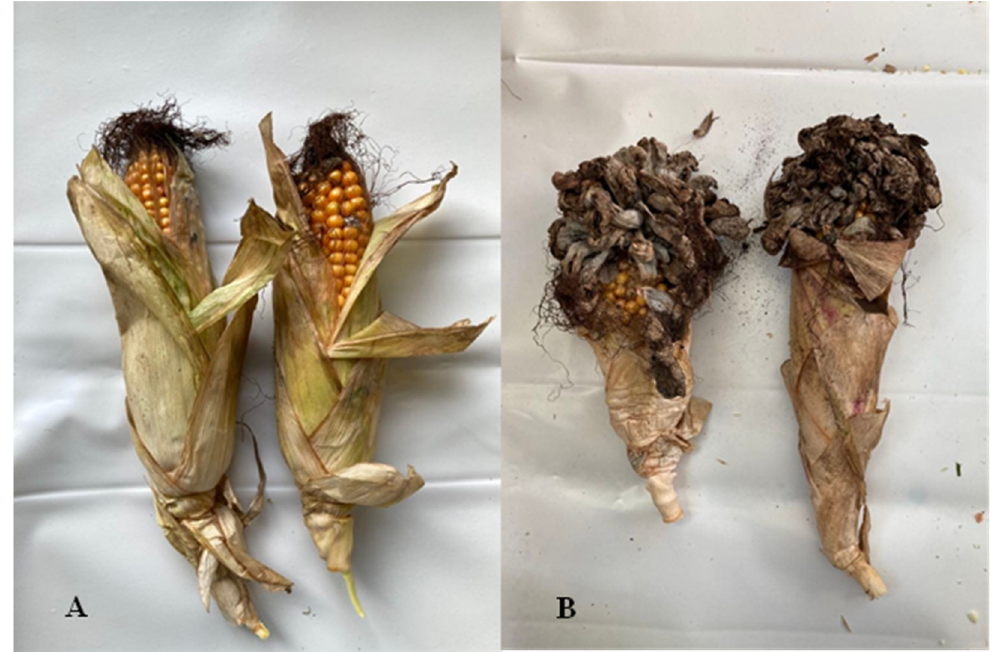
Figure 1. Corn cobs: ( A )—ear not visibly infected with corn smut; ( B )—ear visibly and severely infected with corn smut.